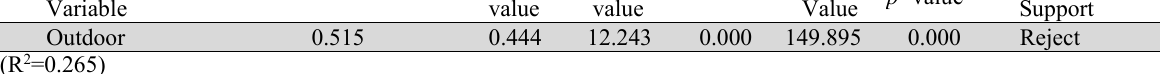
Simple linear regression results for the fourth sub hypothesis of the main first hypothesis Independent